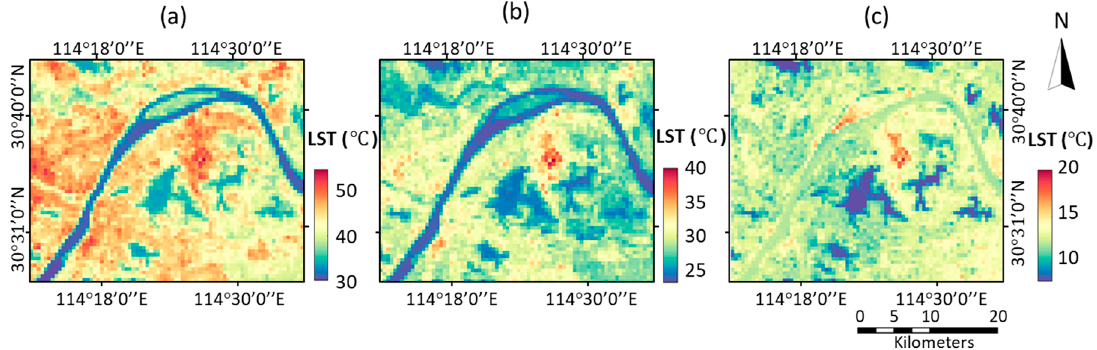
Figure 3. The spatial distributions of the land surface temperatures (LSTs): ( a ) Summer, ( b ) the transition season and ( c ) winter.